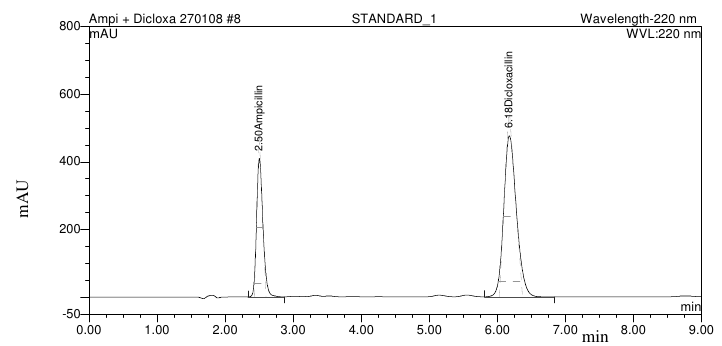
Figure 1. STD chromatogram of ampicilline trihydrate and